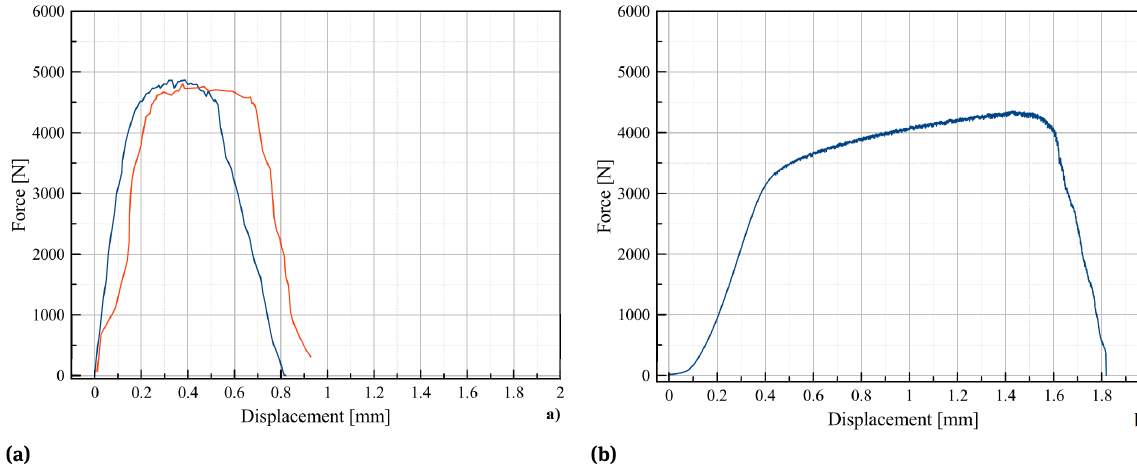
Figure 5: Tensile test force-displacement chart results: a) in normal conditions, b) at elevated temeprature